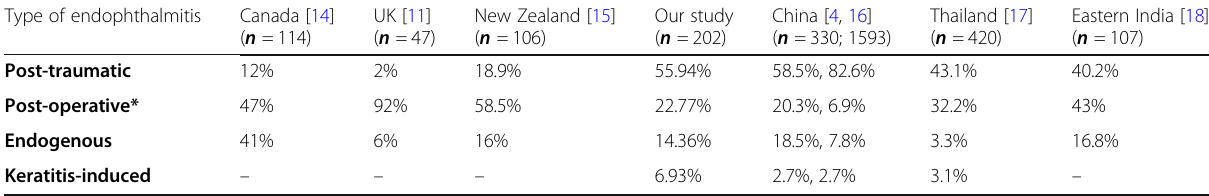
*Includes acute and chronic post-operative, and bleb- and suture-associated